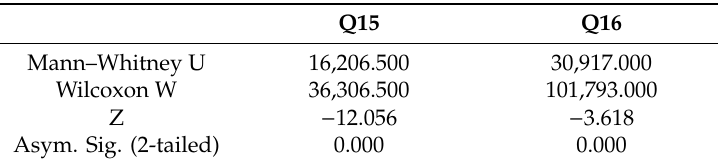
Table 8. Results for non-parametric tests.